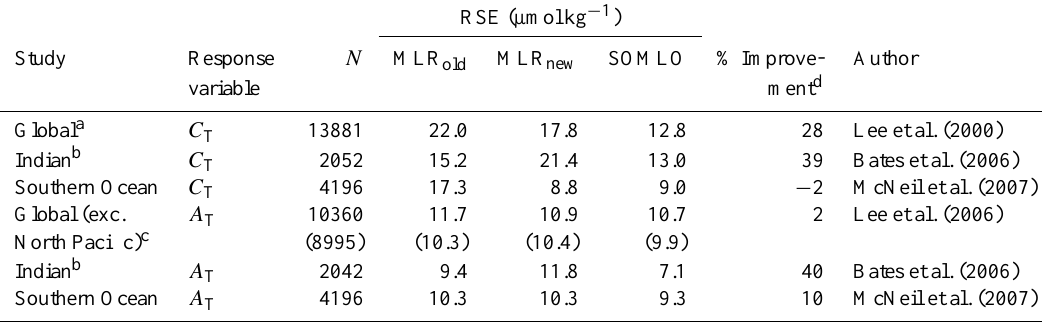
Table 7. Comparison to previous empirical approaches.